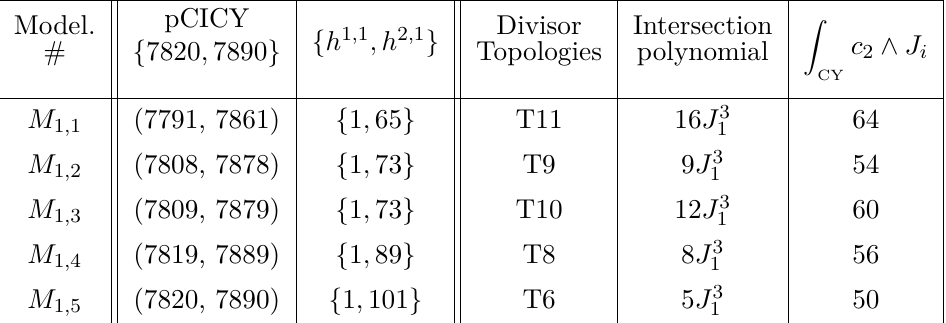
Table 5 . Topological data for favorable pCICYs with h 1 , 1 = 1 . Here, the Hodge number details for the divisor topologies Ti’s are given in table